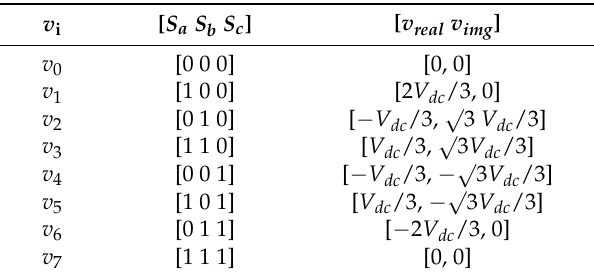
Table 2. Voltage vectors for possible switching